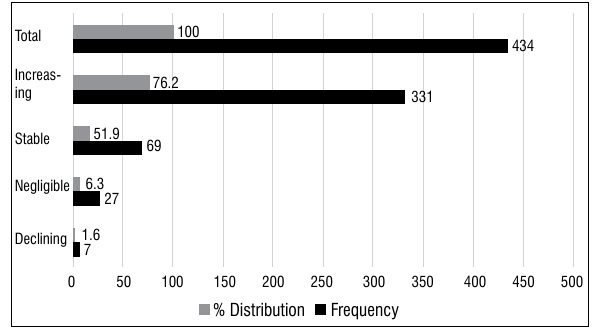
Figure 5: Community perceptions of the severity of drought spells over the years ( n